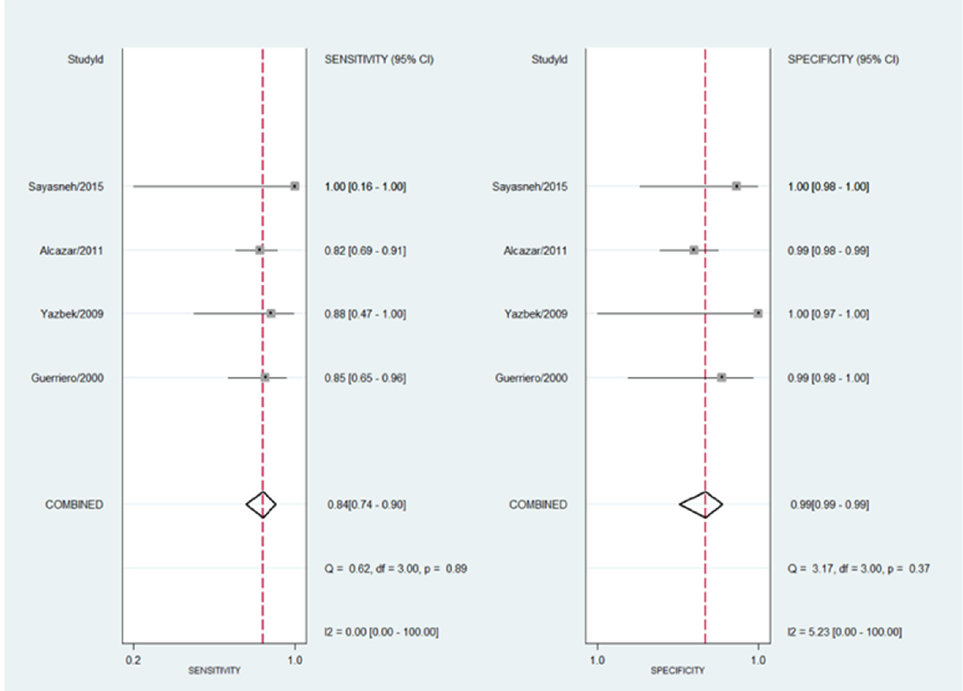
Figure 3. Forest plot for sensitivity and specificity for the four studies with the highest PPV included in the meta-analysis [17,20]. The heterogeneity is shown as well as the pooled estimated sensitivity and specificity. Refs. [16,18,19,21].